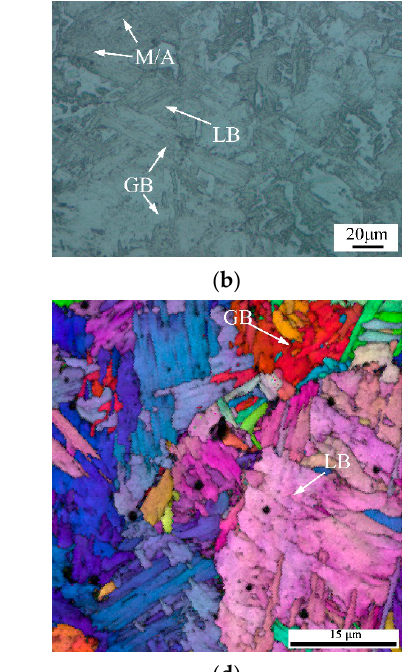
after post-weld heat treatment.